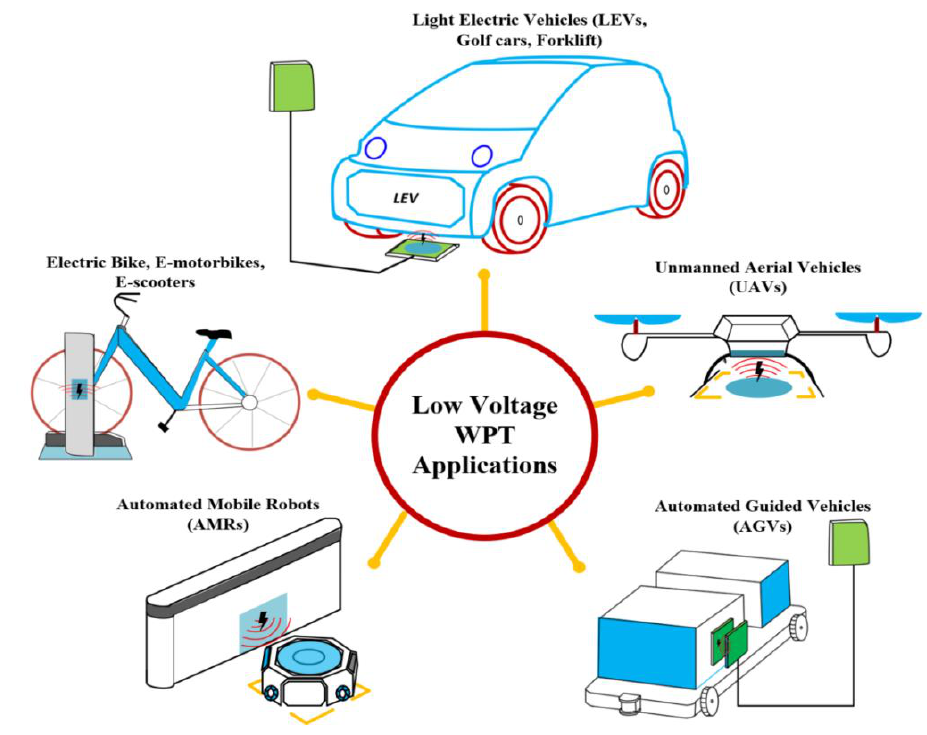
Figure 2. Applications of low-voltage WPT in the mobility sector. Table 1. Details of different light-duty EVs available in the current